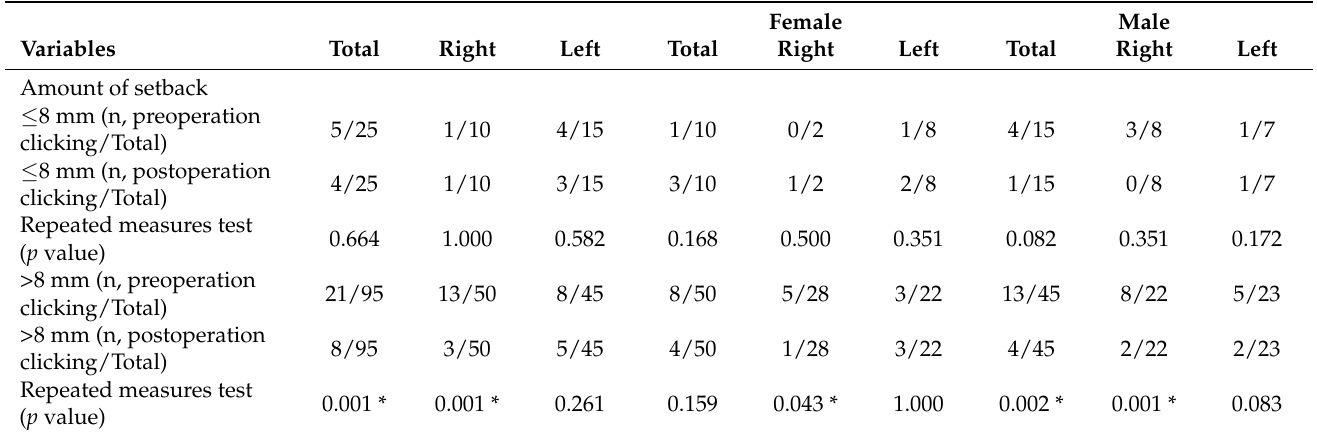
Table 3. The occurrence possibility of postoperative temporomandibular joint clicking in the amount of setback ( ≤ 8 mm and >8 mm) in a repeated measures